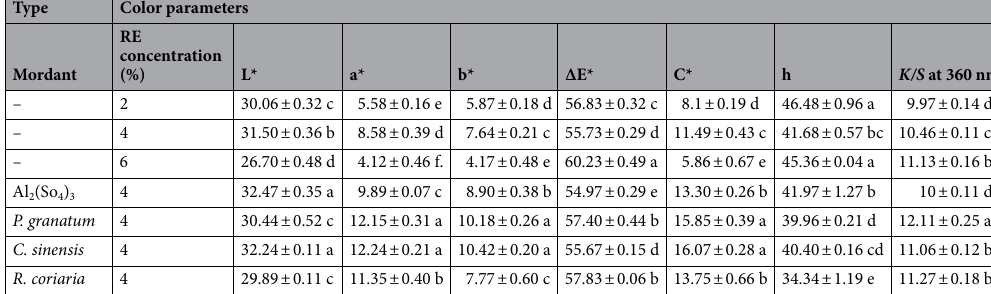
Table 2. Colorimetric properties of wool samples dyed with RE (Color lightness (L*), the degree of redness (+ ve) and greenness (-ve) (a*), and the degree of yellowness (+ ve) and blueness (-ve) (b*), the color strength ( K/S )). a–fMeans within a column followed by the same letter(s) are not significantly different according to Duncan’s multiple range test ( P = 0.05).